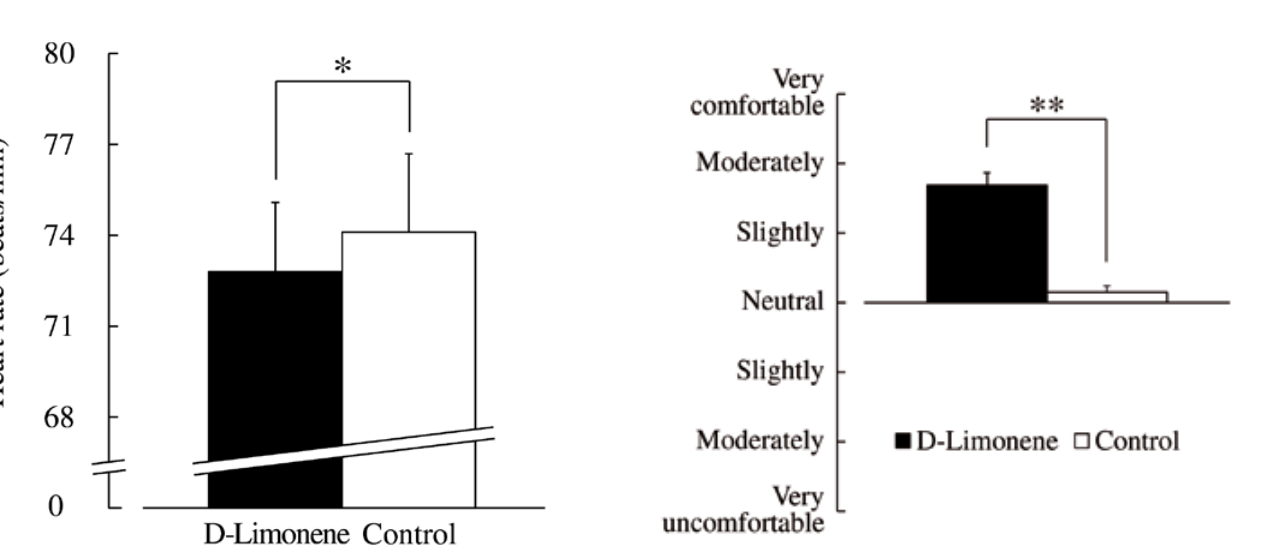
Fig. 4 - Subjective evaluation of “comfortable” measured by a modified semantic differential questionnaire after olfactory stimulation with D-Limonene or control (air). Data are expressed as mean ± SE; n = 13. ** P < 0.01 by Wilcoxon signed-rank